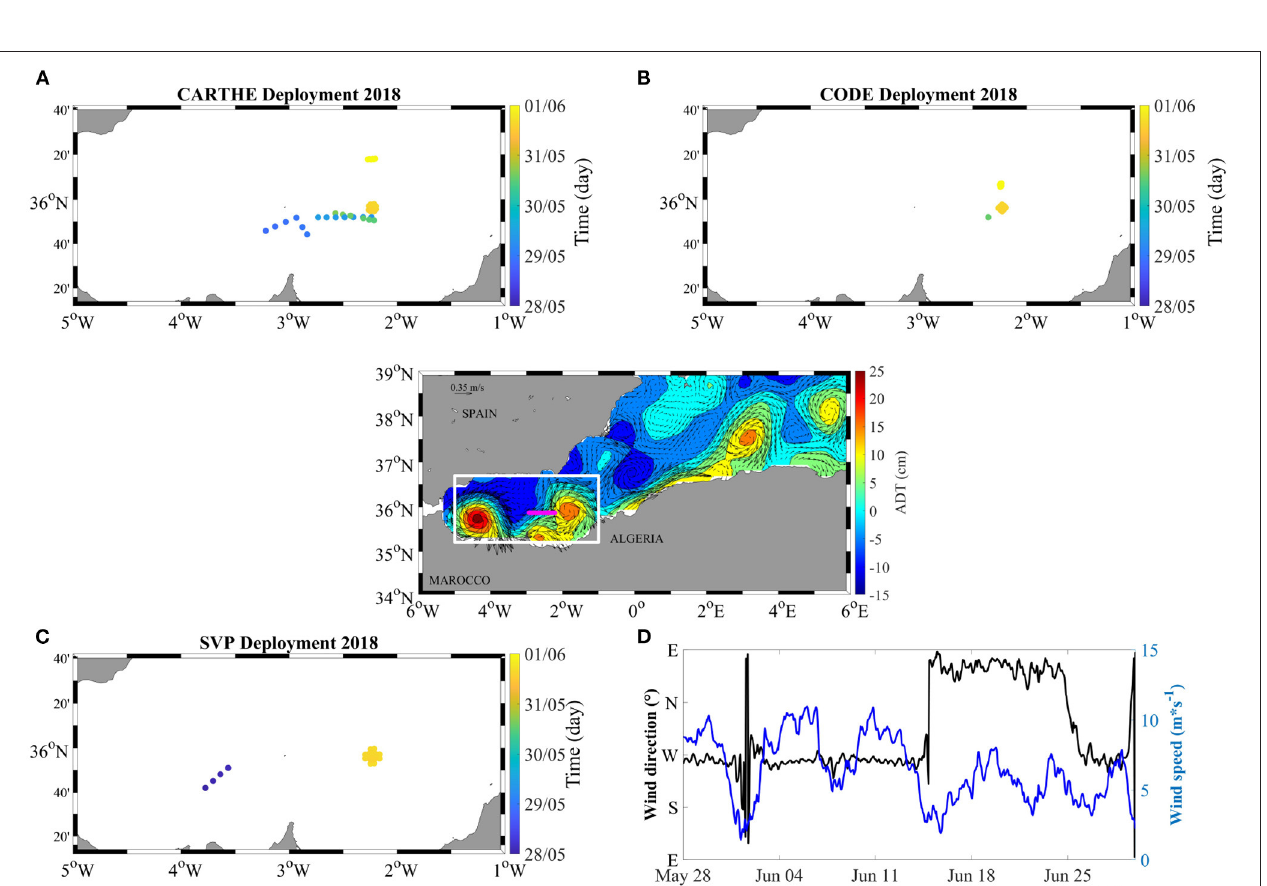
Frontiers in Marine Science |